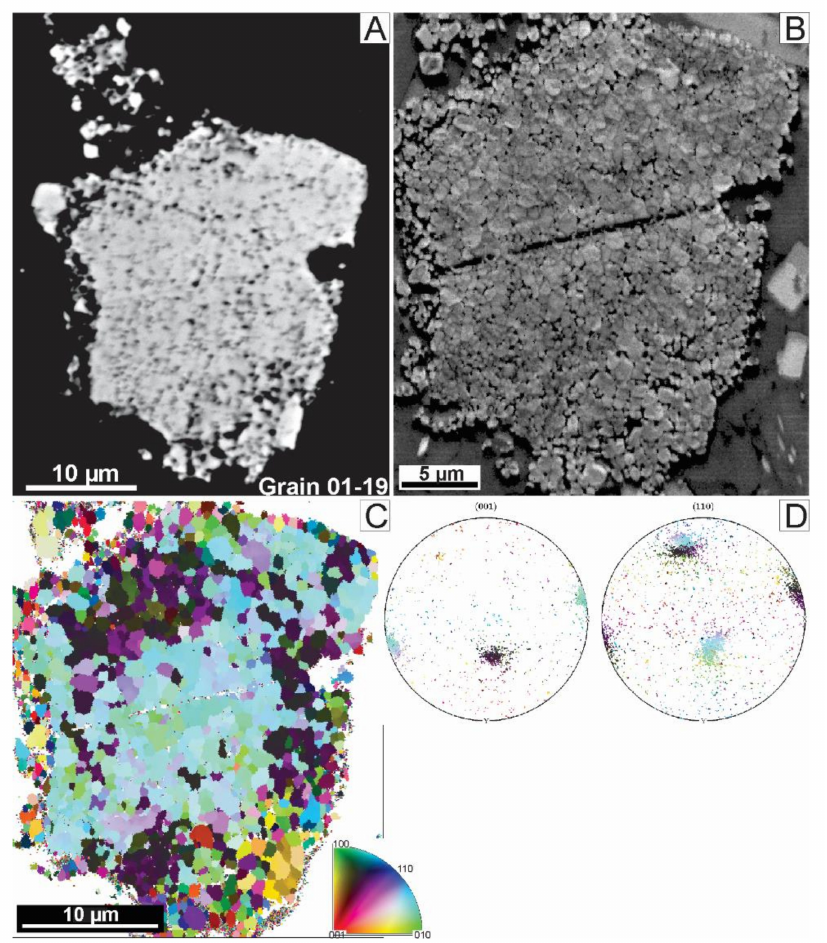
Figure 10. Microstructural details of the granular zircon grain 01-19, located at ca. 2 mm from the PT vein. ( A ) BSE image, the granular texture, and resorbed margins are visible. ( B ) Orientation contrast (FSE) image. ( C ) EBSD map, color-coded in the inversed pole figure (IPF) colors along the [001] axis. Step size 80 nm. ( D ) Upper hemisphere equal angle projection pole figures for [001] and < 110 > , color-coded as in ( C ). Plotted with the MATLAB MTEX